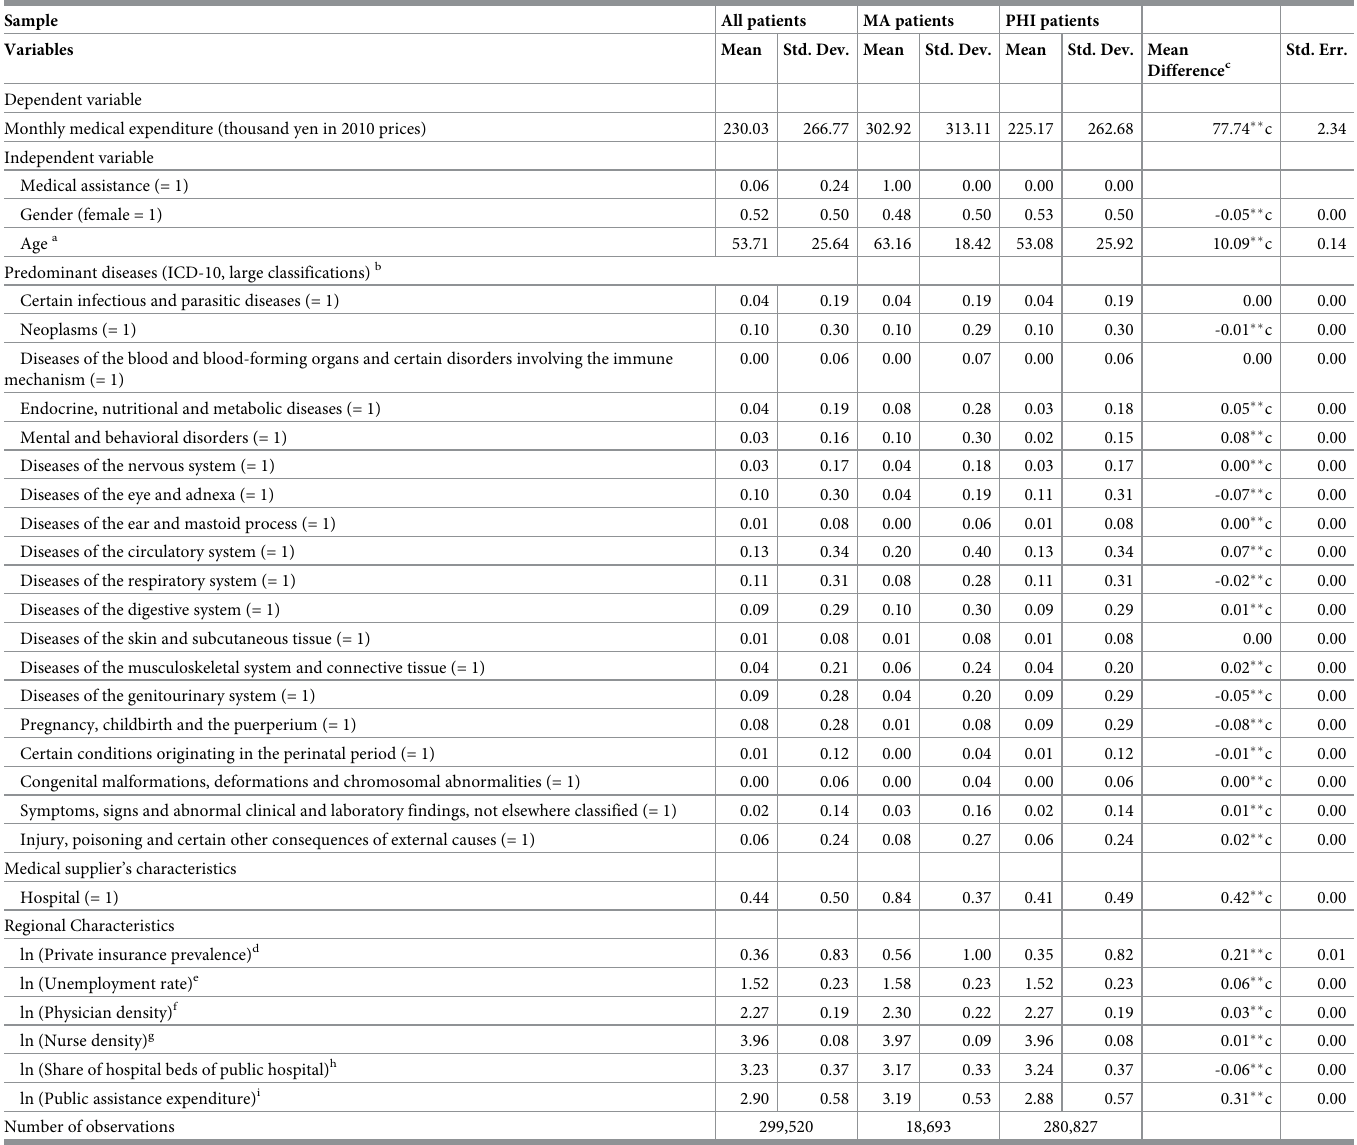
Table 1. Descriptive